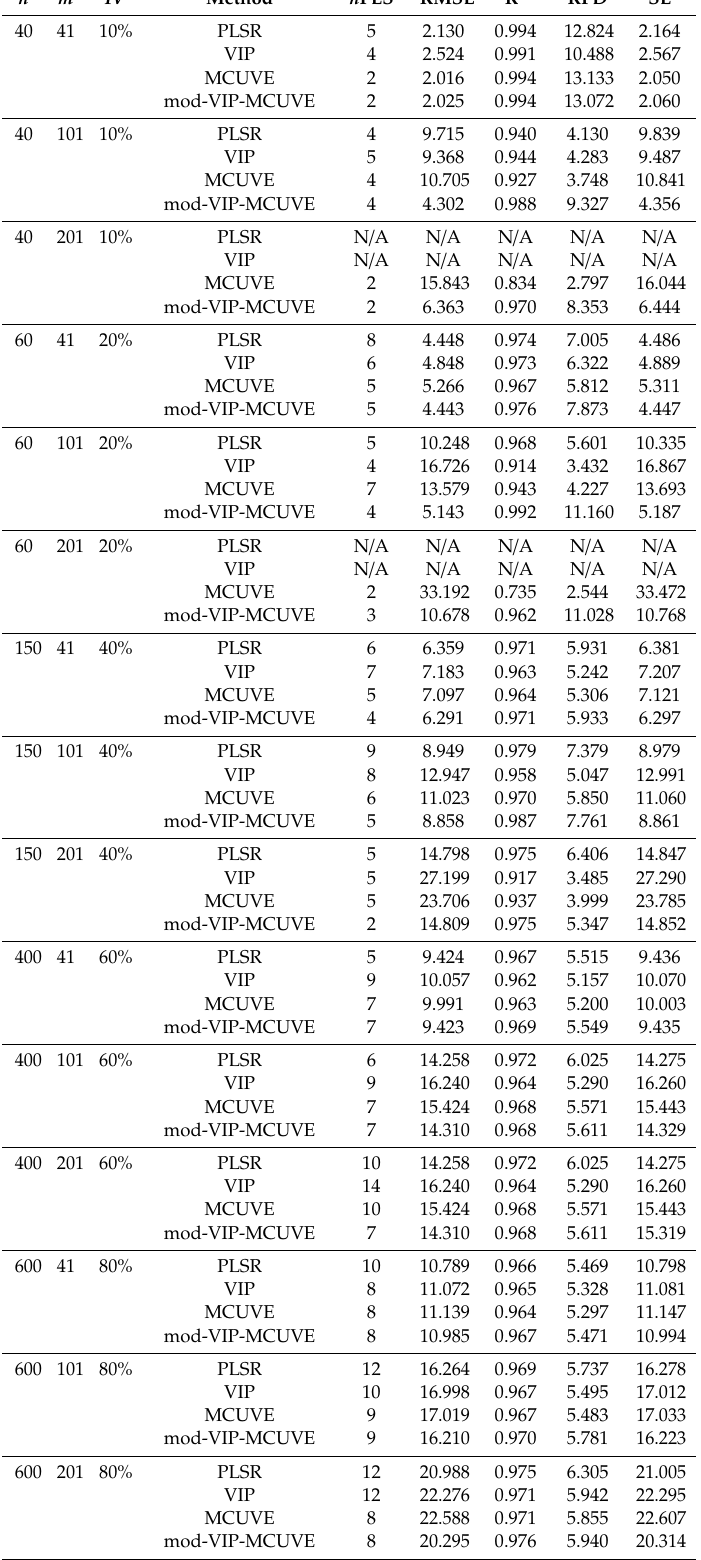
Table 1. The RMSE, R 2 , RPD, and SE in variable selection methods using Monte Carlo Simulation with di ff erent dataset